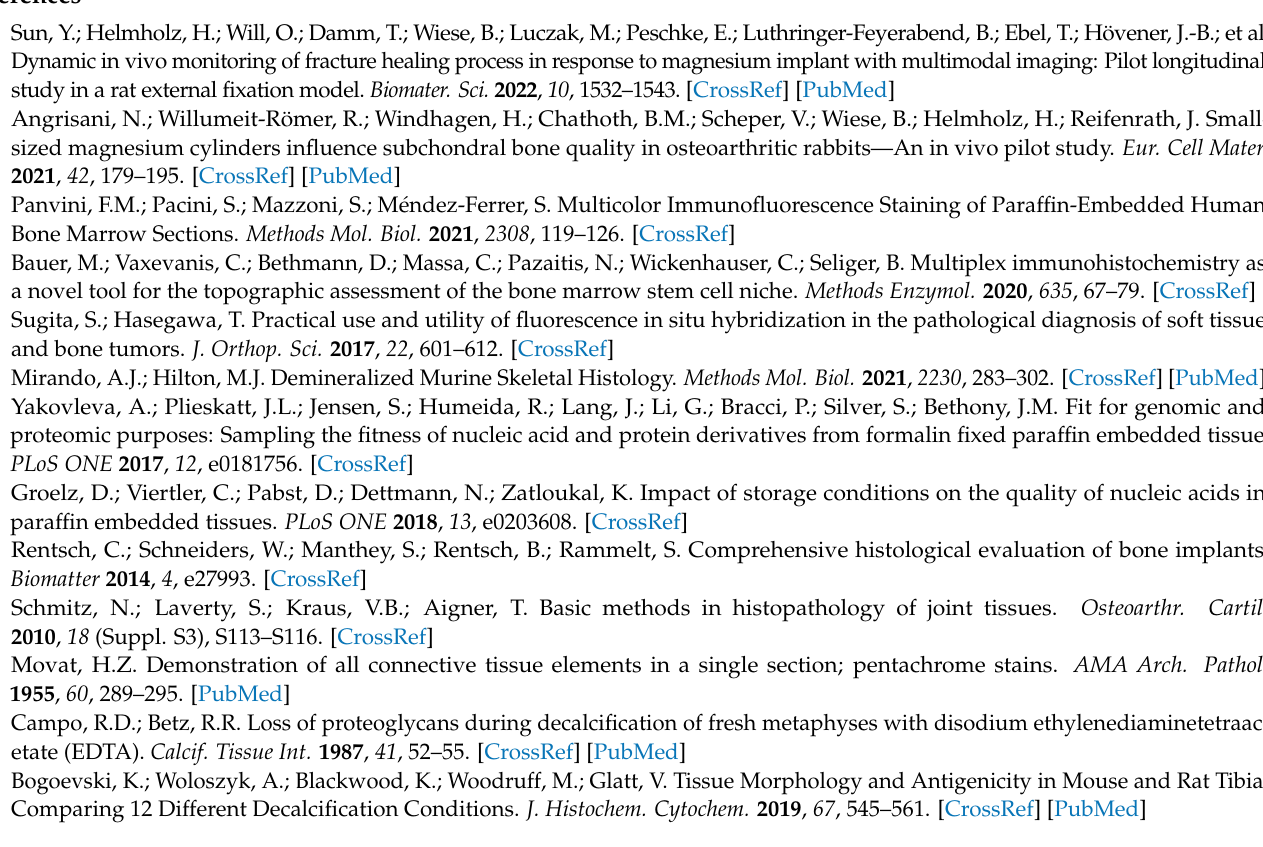
Figure S2. Immunohistochemistry protocol for type-X collagen; Figure S3. Multicolor staining of rat tail vertebra samples decalcified with EDTA and formic acid; Figure S4. Multicolor staining of rat distal femur samples with different section thickness; Figure S5. Multicolor staining of pork